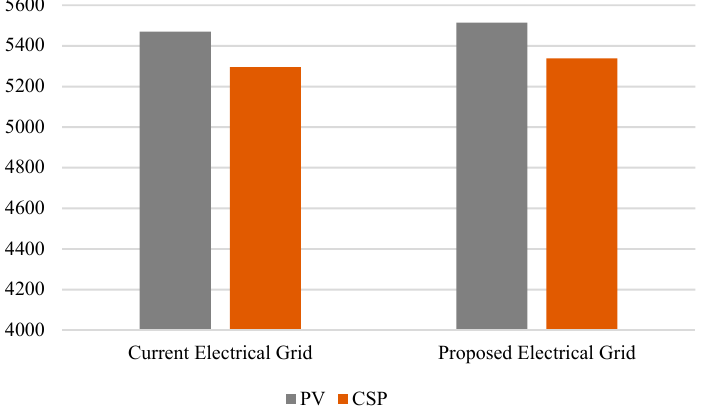
Figure 12. Comparison between the produced H 2 from the current and proposed electrical grid from PV and CSP. Table 10. Amount of H 2 produced at each port using the proposed shortest electric grid in the second pathway from PV and CSP in (kg × 10 6